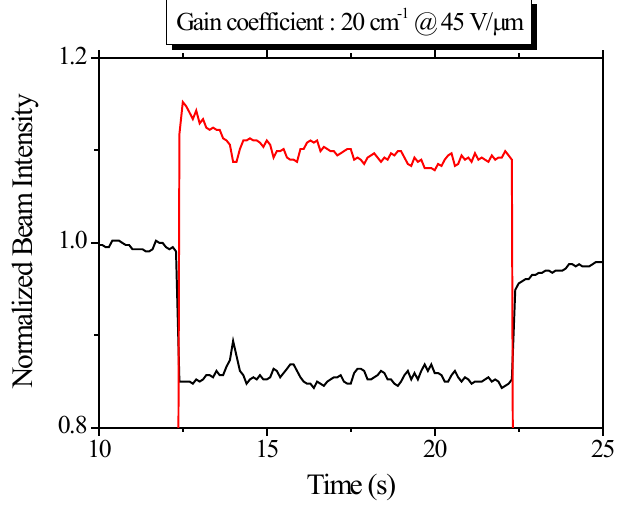
Figure 5. Asymmetric energy transfer measured by two beam coupling (2BC) technique. Beam intensity on y-axis is normalized by the intensity before two beam coupling